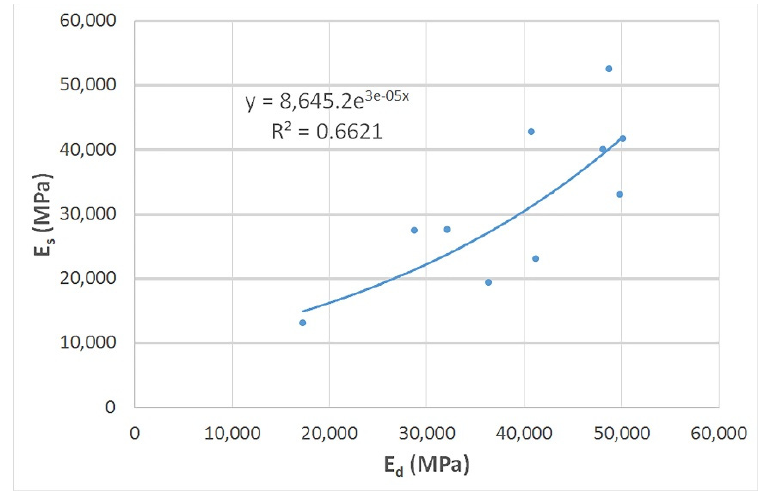
Figure 13. Exponential correlation between dynamic and static elastic modulus.